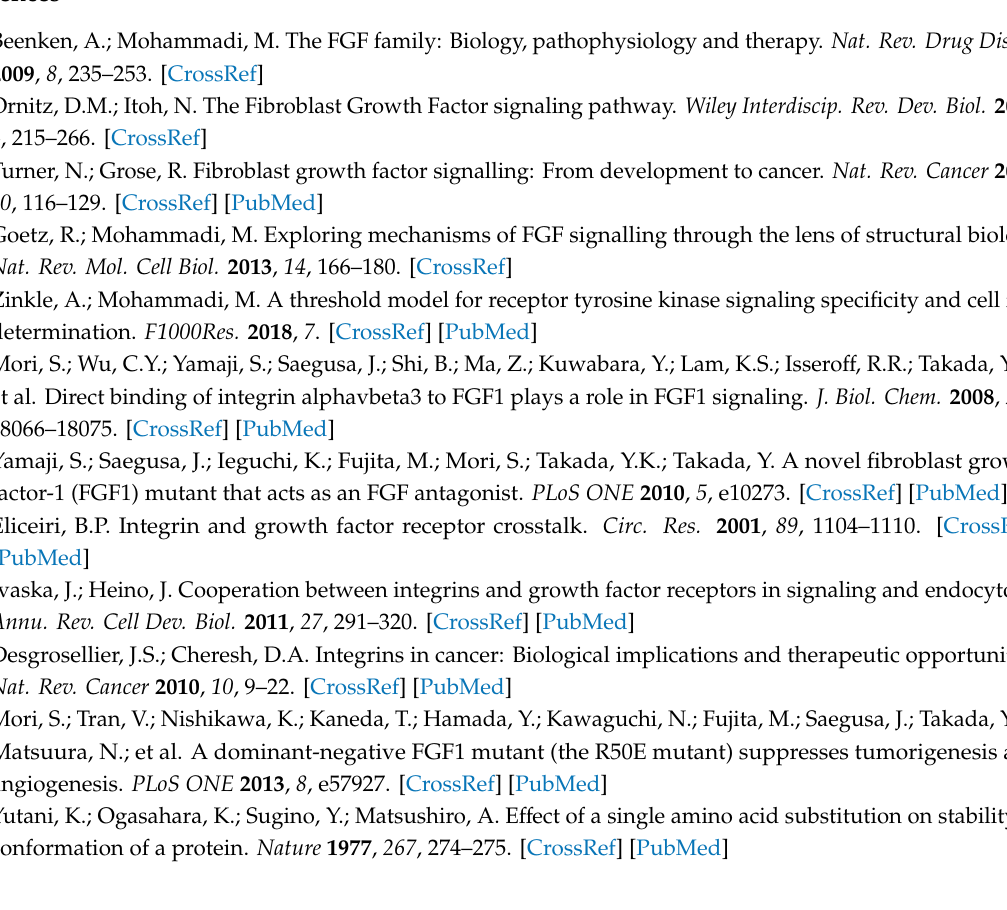
Figure S1. Biological activity of R35E FGF1 mutants. (A) Quantification of cell binding experiment with FGF1 variants presented in Figure 3A. The fluorescence intensity of the wild-type FGF1-DyLight550 in single cells was measured with Zen2.3 software. At least fifteen cells were quantified for each FGF1 variant. Spots represent fluorescence intensities of random individual cells. Black squares represent average fluorescence intensity. (B,C) R35E FGF1 variant can be partially stabilized by the cell surface heparan sulfate glycosaminoglycans. Serum-starved (B) NIH 3T3 cells and (C) BaF3-R1c cells were treated with FGF1 variants at various concentrations (1–100 ng / mL) in the presence of low heparin concentrations (0.36 U / mL). After 48 h viable cells was quantified using AlamarBlue reagent. Proliferative e ff ect was normalized to the maximum response of wild-type FGF1. The data shown are mean values of three independent experiments ± SD. Figure S2. Degradation of R35E mutant. (A) Quantitative comparison of susceptibility of FGF1 variants to proteolysis. Proteolytic degradation of FGF1 variants (200 µ g / mL) by trypsin (15 µ g / mL) was determined based on fluorescence emission intensity at 353 nm upon excitation at 280 nm. (B) Analysis of half-lives of FGF1 variants in NIH 3T3 cell medium and human serum from western blotting experiments presented in Figure 4D. The intensities of the bands were fitted with single exponential decay equation and the half-lives were